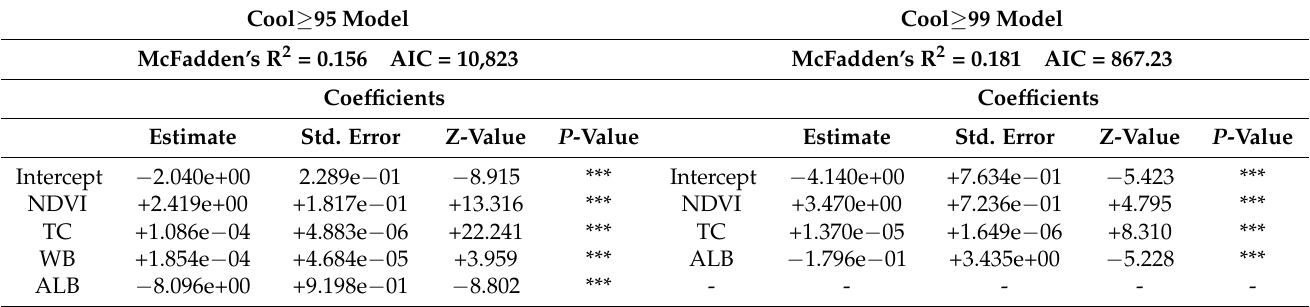
Table 6. Summaries of selected cool-spot logistic Generalized Linear Models.